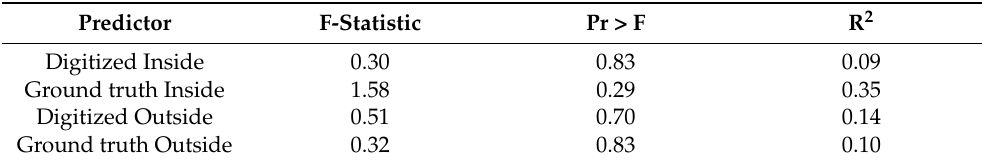
Table 6. Summary of simple linear models relating estimated fuel loading to composition of pyrolysis gases. None of the fitted models were